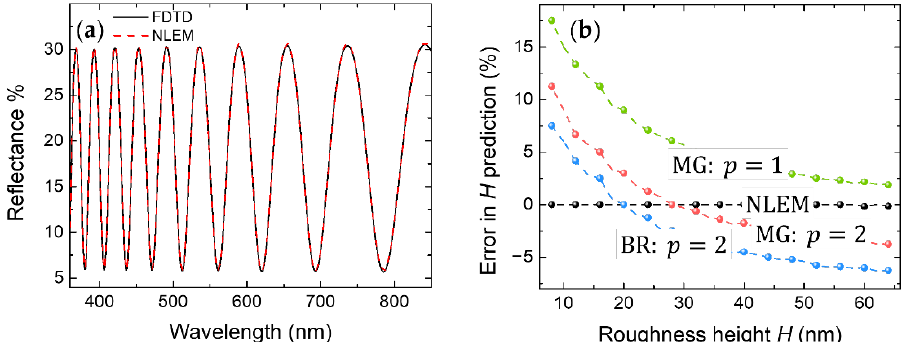
Figure 5. ( a ) FDTD and NLEM reflectance for the SiO 2 /Si system with roughness height H = 32 nm and bulk film thickness of 2 µ m, showing excellent agreement. ( b ) Different effective medium models are tested for predicting the roughness height H , by fitting to corresponding FDTD results. The NLEM model is the only one offering zero-error prediction for all roughness height values.